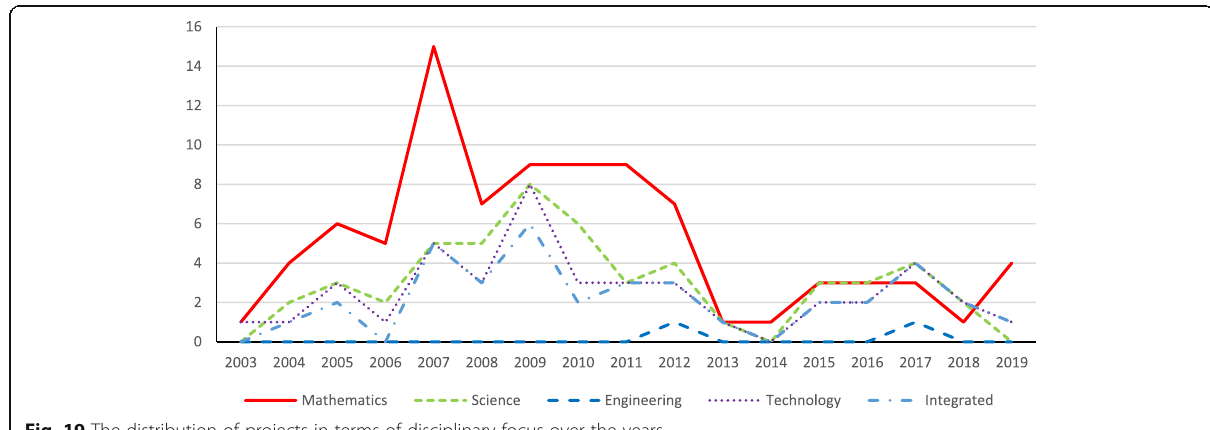
Fig. 19 The distribution of projects in terms of disciplinary focus over the years